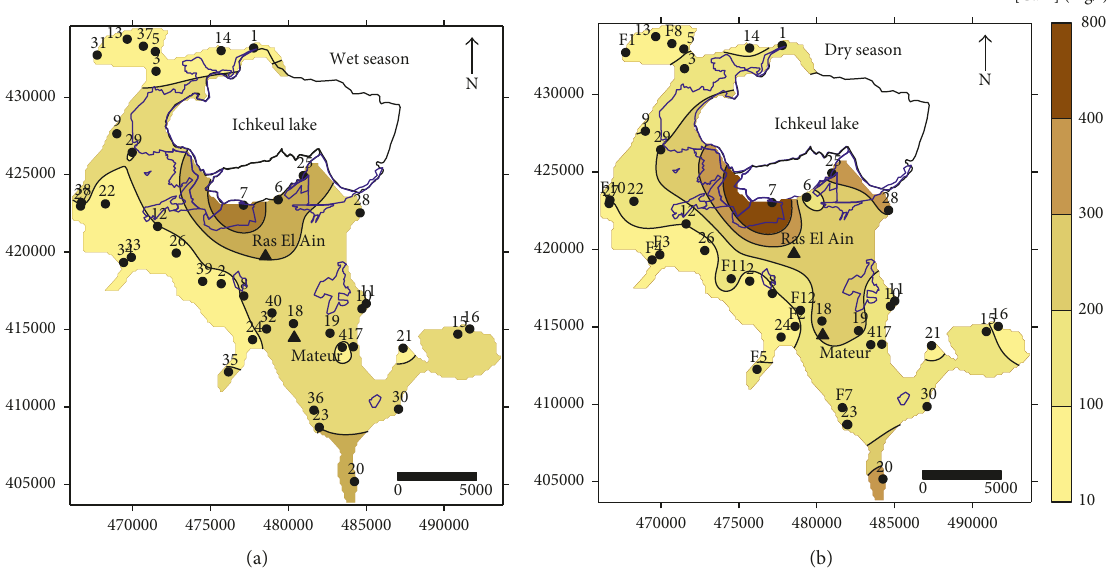
Figure 7: Spatial distribution maps of calcium (Ca ++ ): (a) wet season and (b) dry